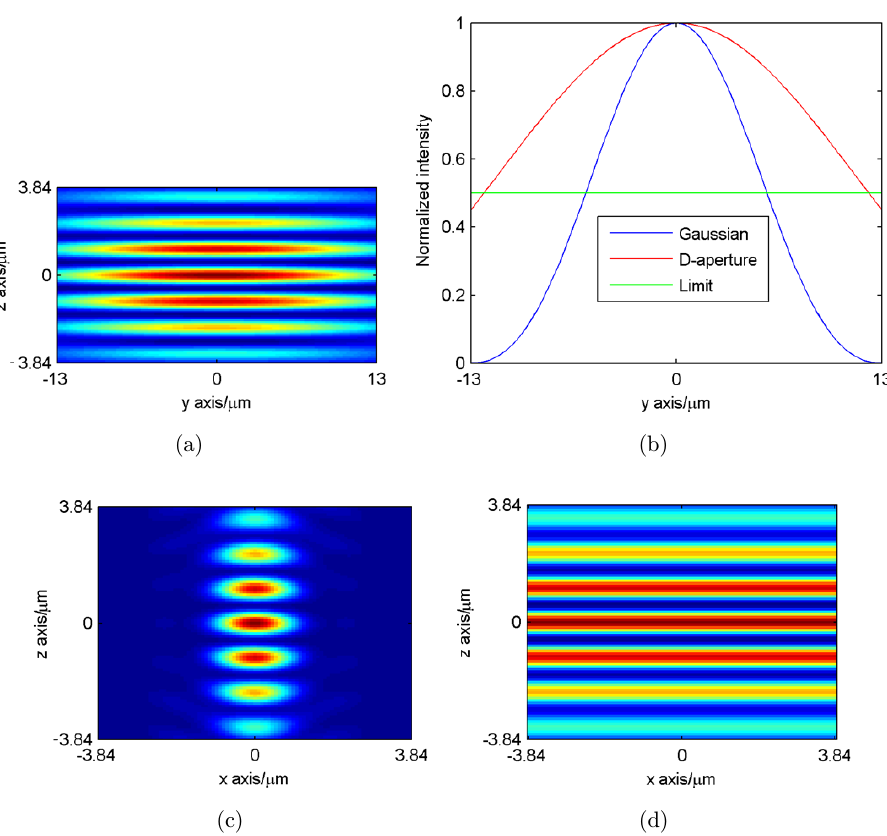
Fig. 9. Intensity distributions. (a) shows the intensity distribution in yz plane, (b) shows the intensity distributions of Gaussian light sheet and multi-light sheets along y -axis, (c) shows the intensity distribution in zx plane at outside position and (d) shows multi light sheets. position of y ¼ 12 : 5 (cid:2) m along z axis and in zx plane